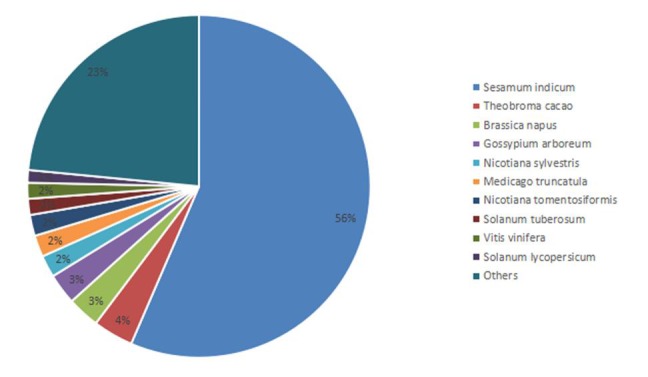
The Species distribution of Nr annotations.